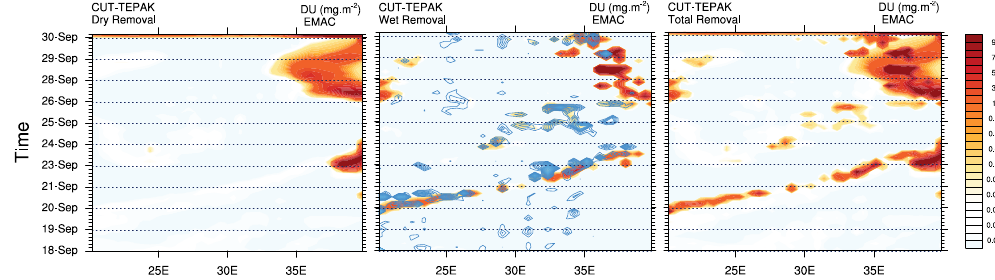
Figure 12. Time evolution of dry, wet and total removal of dust at CUT-TEPAK; (blue) TRIMM observations, (orange) EMAC precipitation Figure 11. Time evolution of dry, wet and total removal of dust at CUT-TEPAK; (blue) (see TRIMM observations, (orange) EMAC precipitation (see text).